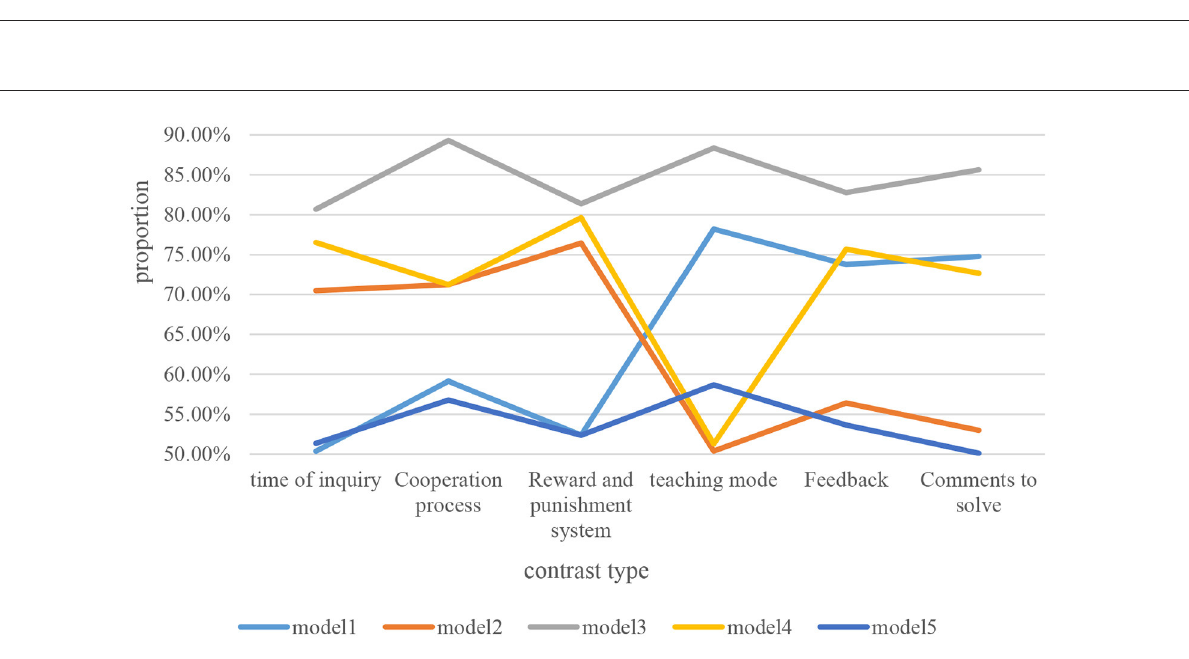
improvement and development to enhance the interaction between teachers and